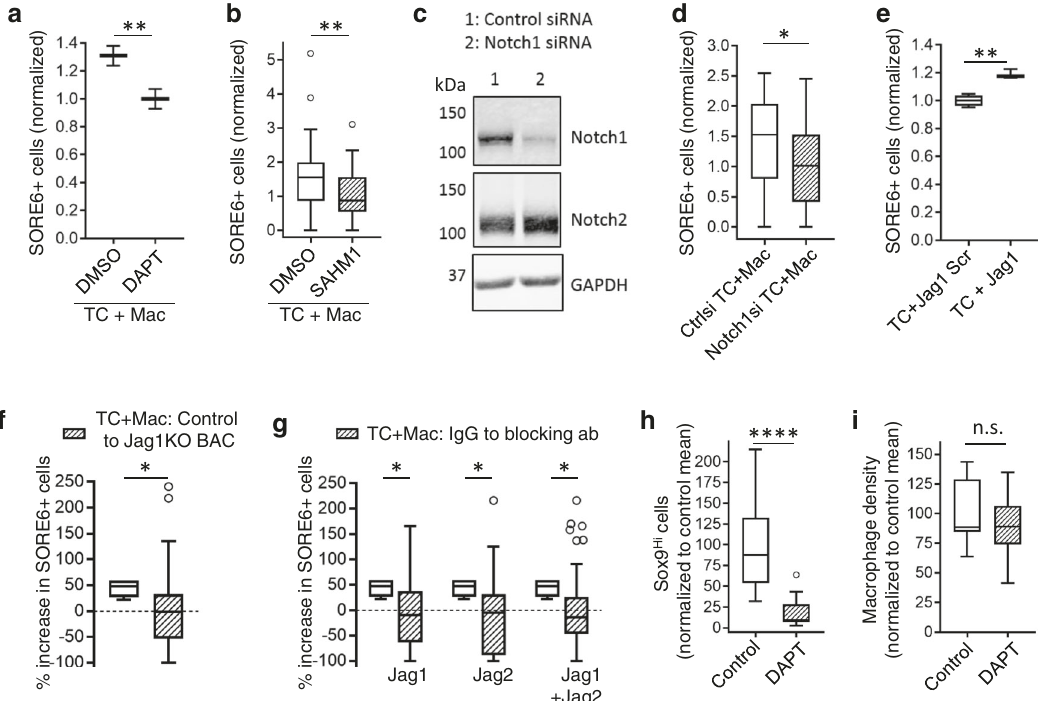
Fig. 5 Notch1-Jagged signaling regulates macrophage contact-induced stemness in breast cancer cells. a Quanti fi cation of SORE6 + cells in TC + Mac co-cultures treated with DMSO or DAPT. n = 60 fi elds at ×20 magni fi cation; data normalized to the DAPT mean; unpaired two-tailed Student ’ s t -test, ** p = 0.0061. b Quanti fi cation of SORE6 + cells in TC + Mac co-cultures treated with DMSO or 20 µ M SAHM1. n = 48 (DMSO), 47 (SAHM1) fi elds at ×20 magni fi cation; data normalized to the SAHM1 mean; two-sided Mann – Whitney test, ** p = 0.0025. c Western blotting showing Notch1 KD in Notch1 siRNA-treated SORE6 MDA-MB-231 cells after 48 h. It is noteworthy that Notch2 levels are unaffected by Notch1 siRNA. Source data are provided as a Source Data fi le. d Quanti fi cation of SORE6 + cells in TC + Mac co-culture assay. Tumor cells were treated with either control siRNA or Notch1 siRNA for 36 h and co-cultured with macrophages overnight. Measurements were made 48 h post siRNA transfection. n = 32 fi elds of 330 × 330 µ m 2 ; data normalized to the Notch1si condition mean; unpaired two-tailed Student ’ s t -test, * p = 0.0232. e Quanti fi cation of SORE6 + cells in tumor cells (MDA-MB- 231-expressing tdTomato and with SORE6>GFP) treated with either Jagged1 scramble peptide or functional Jagged1 peptide. n = 80 fi elds at ×20 magni fi cation; data normalized to the TC + Jag1 scramble mean; unpaired two-tailed Student ’ s t -test, ** p = 0.0012. f Change in % SORE6 + cells after co- culture with either wild-type BACs compared to tumor cells alone (40% increase, data from Fig. 4d, unshaded box) or Jag1KO BACs compared to wild-type BACs (no change, shaded box). n = 50 (wild-type BACs) and 53 (Jag1KO BAC) fi elds at ×20 magni fi cation; two-sided Mann – Whitney test, * p = 0.033. g Change in % SORE6 + cells after co-culture with either wild-type BACs compared to tumor cells alone (40% increase, data from Fig. 4d, unshaded boxes) or Jag1/Jag2 antibody treatments compared to IgG-treated sample (no change, shaded boxes). n = 54 (IgG), 57 (Jag1), 56 (Jag2), and 55 (Jag1 + Jag2) fi elds at ×20 magni fi cation; two-sided Mann – Whitney test, * p -values: Jag1 = 0.035, Jag2 = 0.013, Jag1 + Jag2 = 0.02. h Quanti fi cation of changes in Sox9 Hi cells in fi xed PyMT mammary tumor after PBS (control) or DAPT treatment. n = 5 and 7 mice for control and DAPT conditions; two 2 – 6 mm 2 tumor tissue areas were analyzed in each mouse; unpaired two-tailed Student ’ s t -test, **** p < 0.0001. i Quanti fi cation of changes in macrophage density in fi xed PyMT mammary tumor after PBS (control) or DAPT treatment. n = 5 and 7 mice for control and DAPT conditions; two 2 – 6 mm 2 tumor tissue areas were analyzed in each mouse; unpaired two-tailed Student ’ s t -test, n.s. p = 0.41. In all quanti fi cations, boxes indicate 25th – 75th percentile interquartile range (IQR) and central line indicates the median. Top and bottom whiskers were plotted using Tukey ’ s method and extend to 75th percentile + 1.5 × IQR and 25th percentile − 1.5 × IQR, respectively. Points below and above the whiskers are drawn as individual